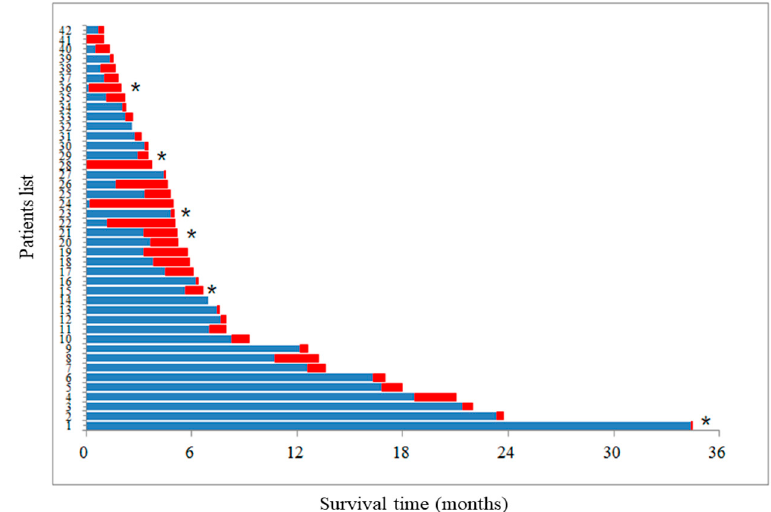
Figure 2. The time interval between the initiation of chemotherapy to aTE occurrence (blue color) and from aTE occurrence to patient’s death (red color). * indicates patients who received anticoagulants before aTE occurrence.